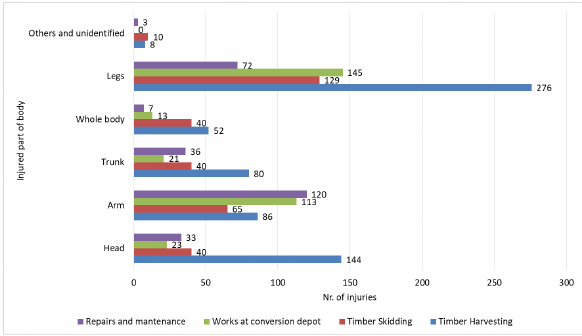
Figure 2: Workplace injuries according to injured body parts in State forestry enterprise (years 2000-2017)